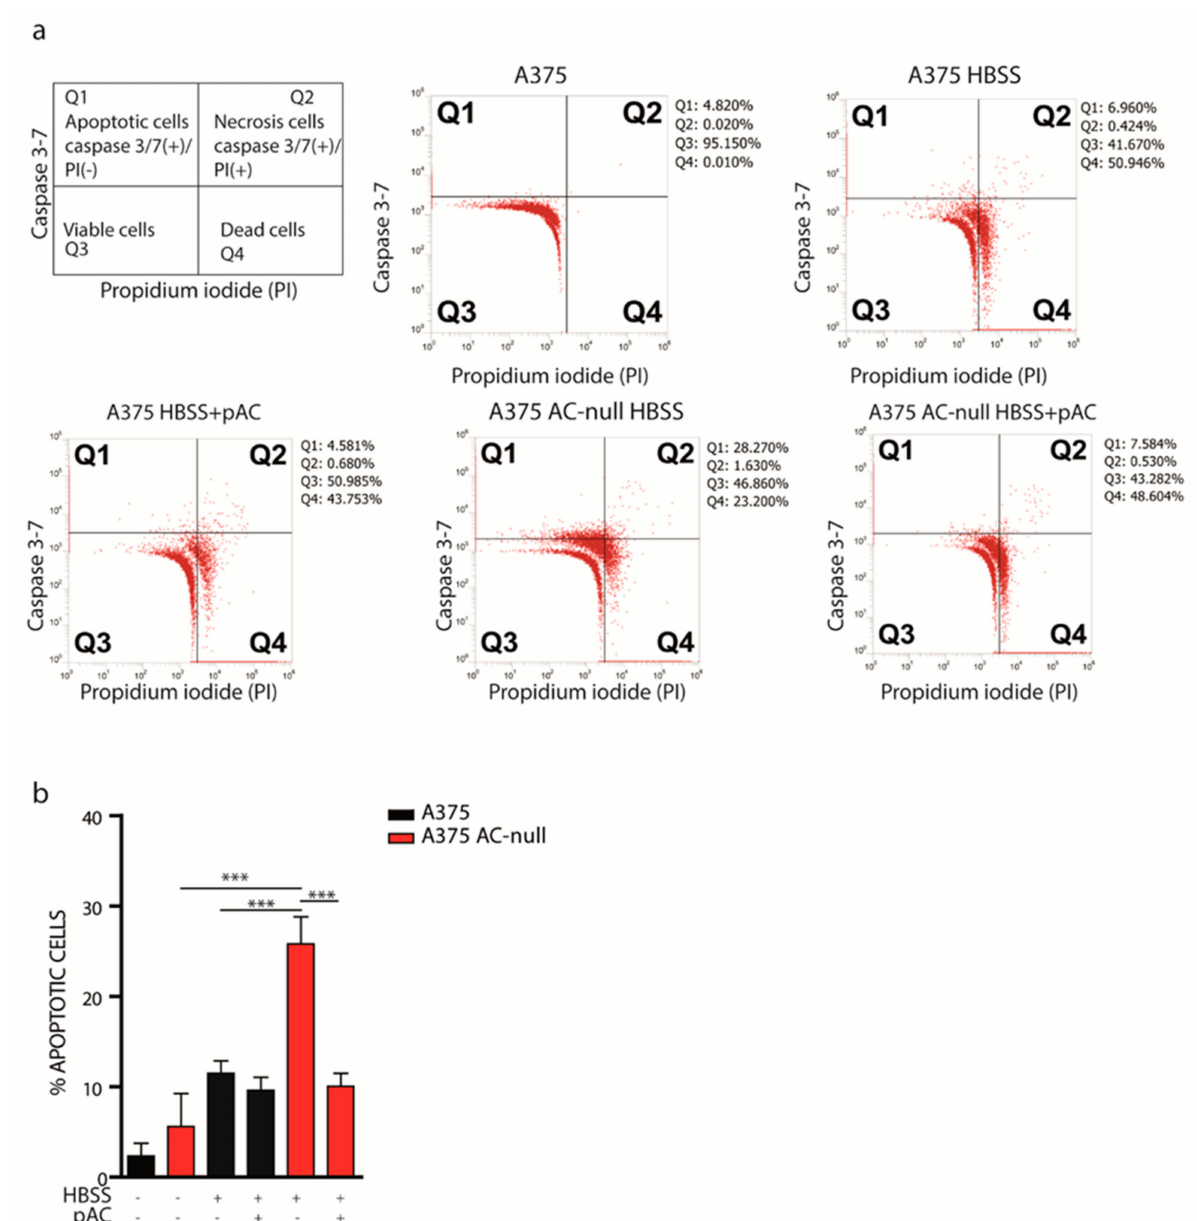
Figure 3. AC ablation promotes apoptosis after total nutrient deprivation. ( a ) A375 and A375 AC-null cells were transfected or not with pAC and after 24 h were starved with HBSS medium for 2 h. Cells were then harvested, stained with Caspase 3-7/SYTOX (propidium iodide), and analyzed by flow cytometry as presented in the illustration. ( b ) Flow cytometry analysis performed on cells in Q1 show an increased number of apoptotic cells in A375 AC-null cells. Moreover, recovery transfection using pAC decreased the amount of apoptotic cells in A375 AC-null cells, while no substantial differences were observed in WT A375 cells, transfected or not with pAC. Experiments were performed in three biological and technical replicates, data are expressed as mean ± SD (*** p < 0.001, Student’s t-